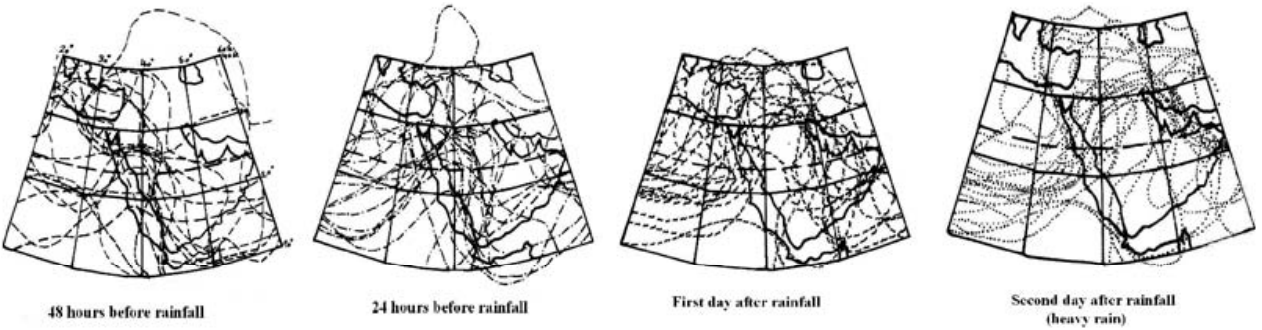
second day of heavy rainfalls (right pictures). Fig. 20 The location of the 500 hPa LA centers of the 20 selected floods two days